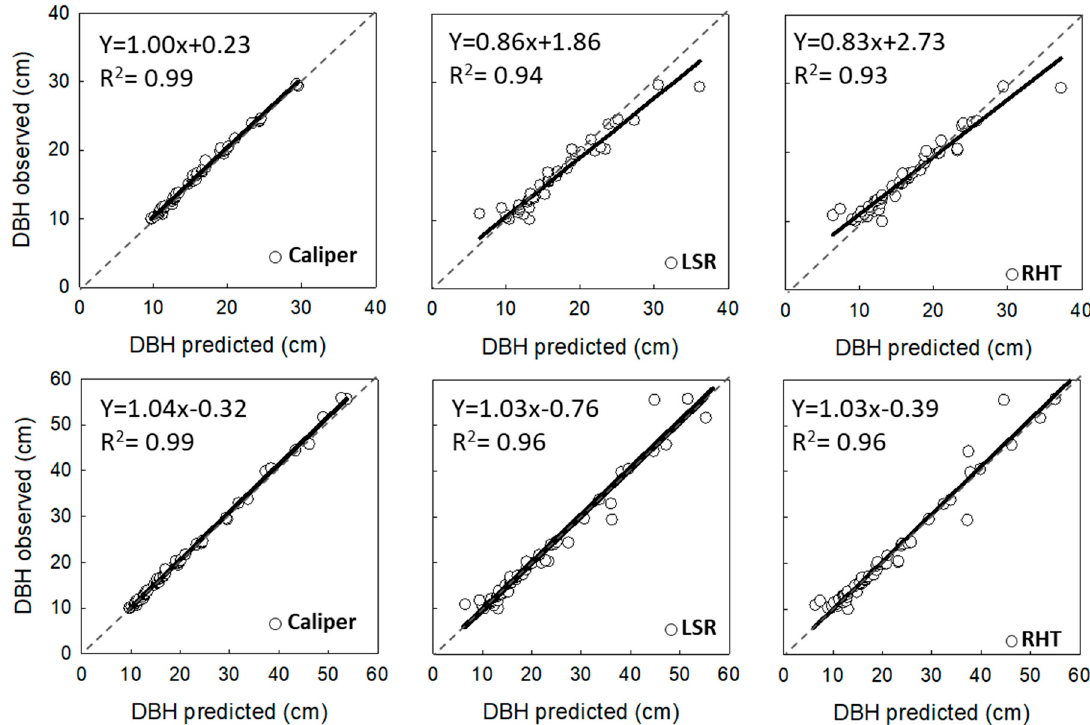
Figure 5. The observed (tape measured) DBHs versus the DBH measured with the caliper from the field map bundle and extracted from the terrestrial laser scanning (TLS) point cloud using two different methods—TLS RHT and TLS LSR —estimated for different tree size classes: DBH 10–30 (upper panel) and DBH All (lower panel): The solid lines represent the adjusted linear models, and the dashed lines represents the 1:1 lines (Y = X).